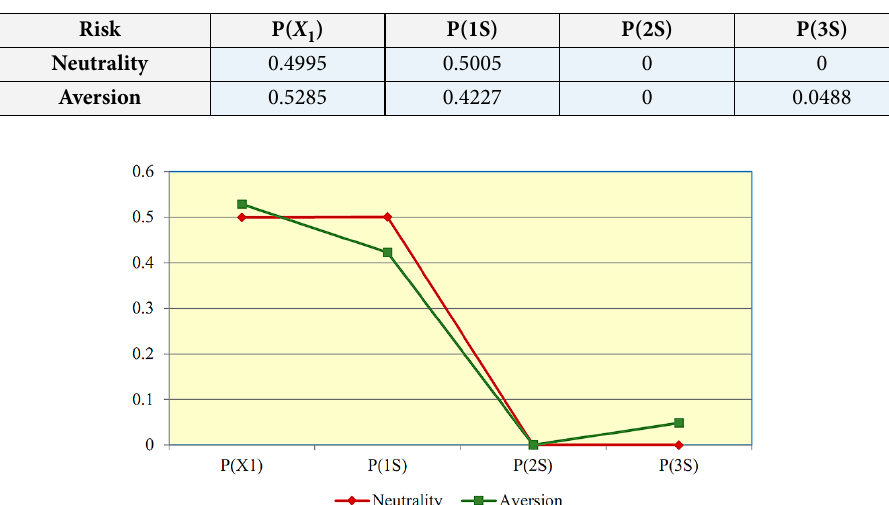
Table 10. Equilibrium probabilities in the two observations setting